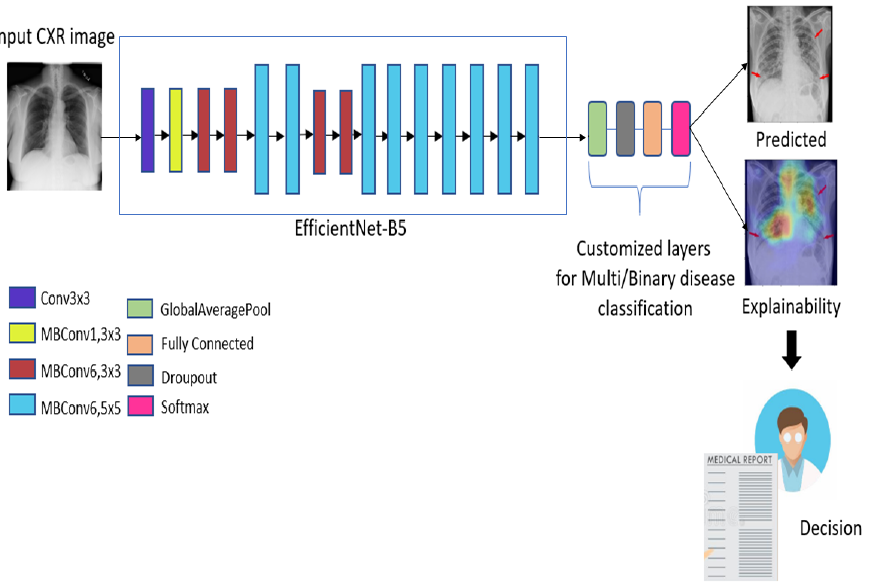
Figure 2. Proposed DeepCCXR architecture for COVID-19